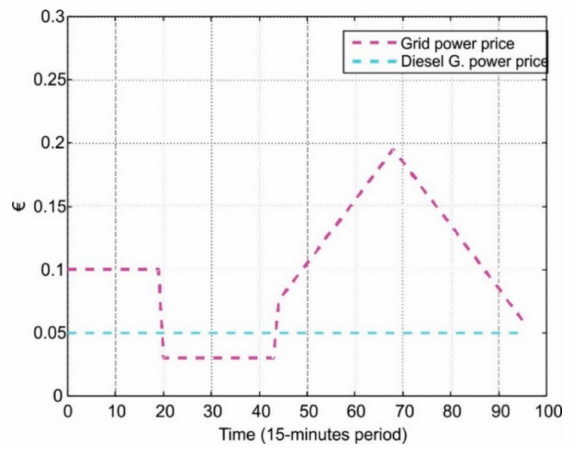
Figure 10. Generated power price [42].